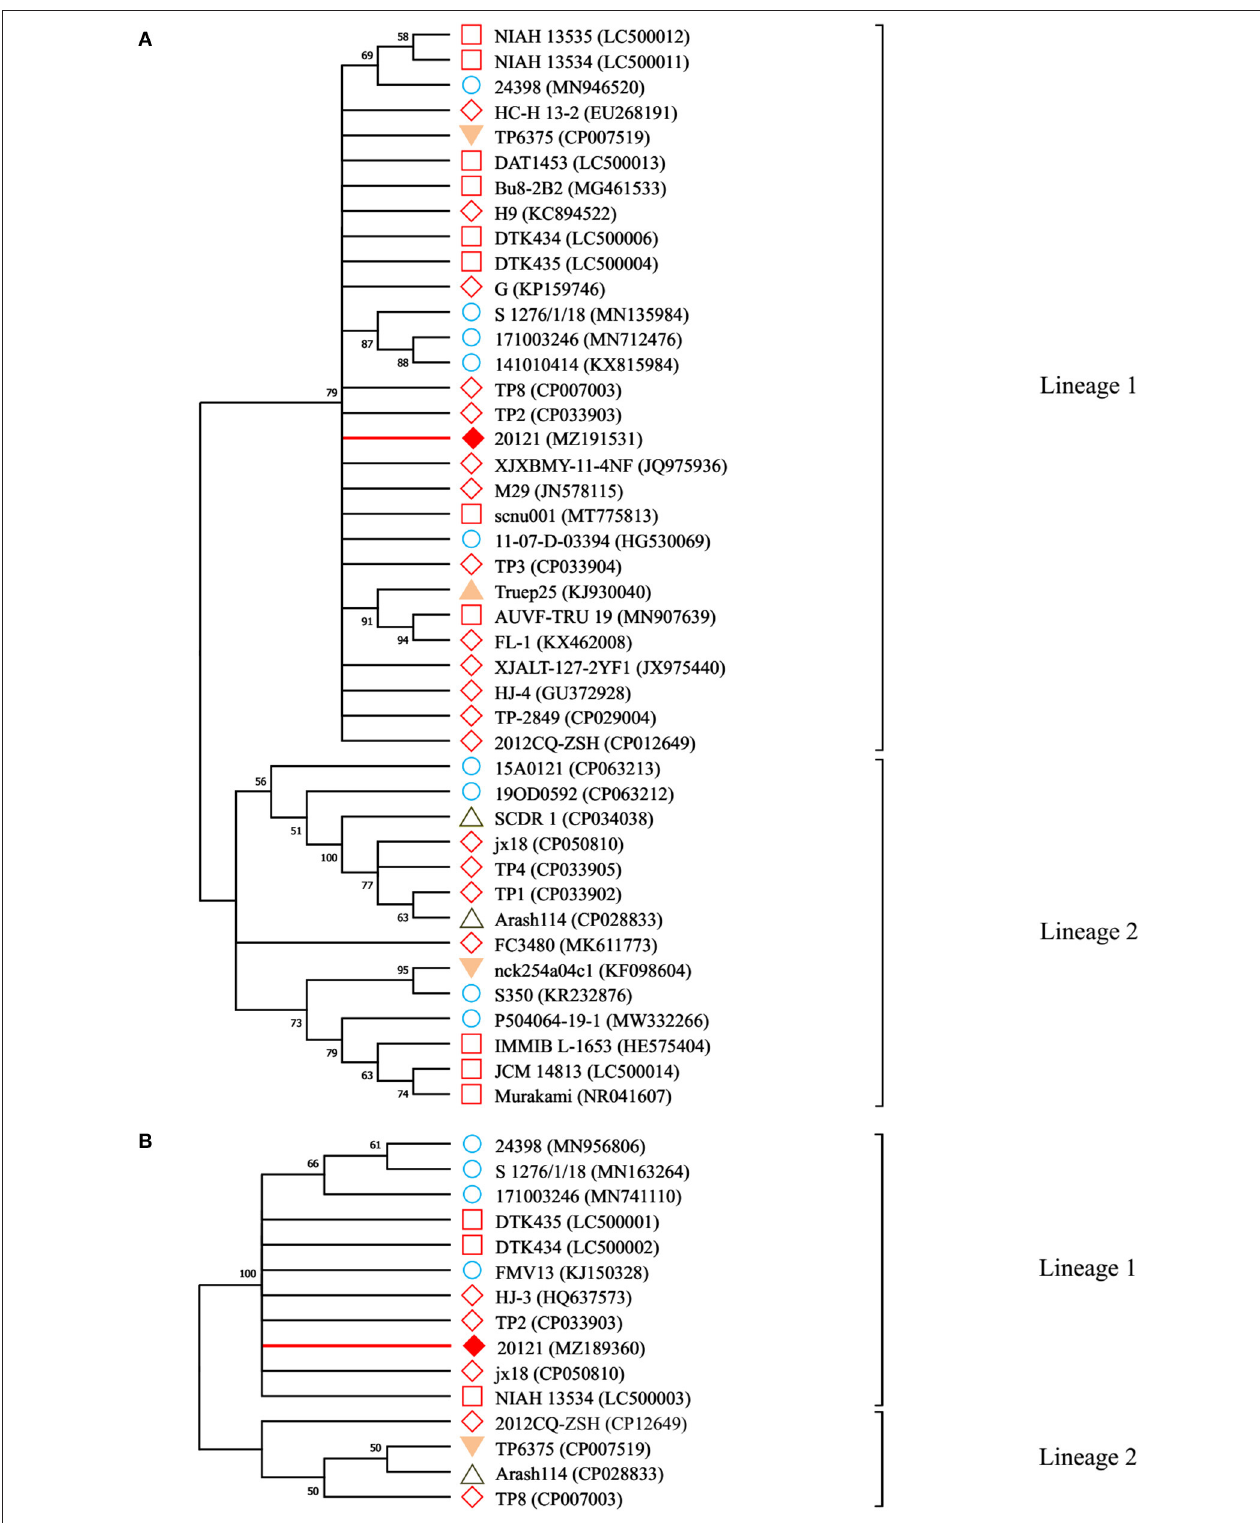
FIGURE 2 | Neighbor-joining phylogenetic trees for 16S RNA and plo genes. A : the phylogenetic trees for 16S RNA gene; B : the phylogenetic trees for plo genes. Branches corresponding to partitions reproduced in < 50% bootstrap replicates are collapsed. The percentage of replicate trees in which the associated taxa clustered together in the bootstrap test (1,000 replicates) are shown above the branches. (cid:7) denotes the genes sequenced in this study; ♦ indicates the reference sequences isolated from China; while (cid:3) indicates sequences isolated from the rest of Asia; ◦ are sequences isolated from European countries; △ indicates isolated reports from the Middle Eastern countries, N was from a South American country and H denotes isolates from North American countries.